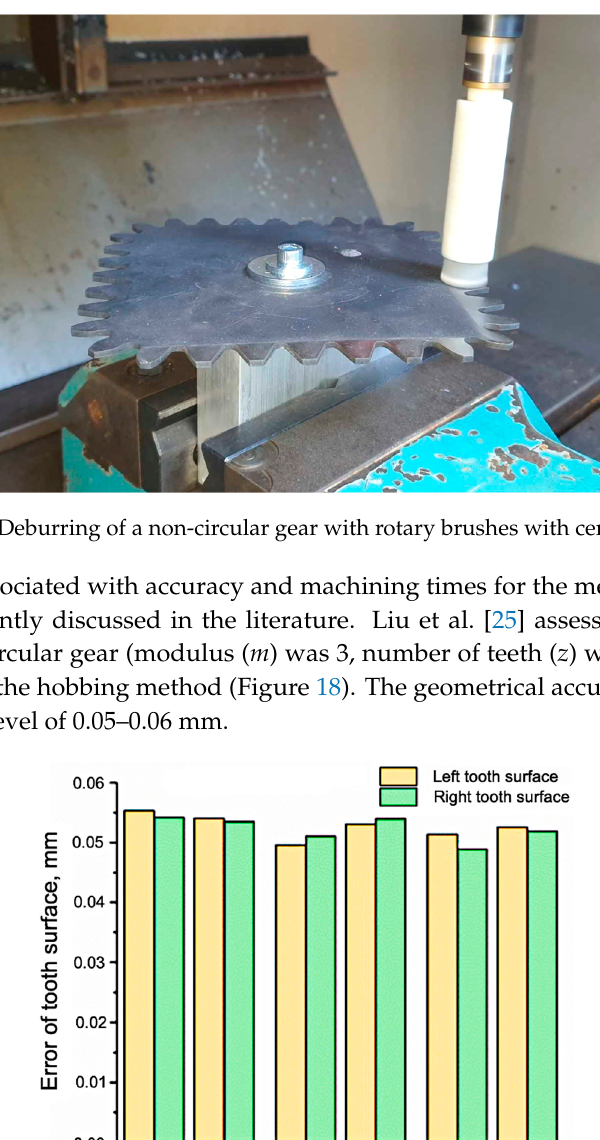
10 of 13 Figure 16. CMM (Coordinate Measuring Machine) measuring report.